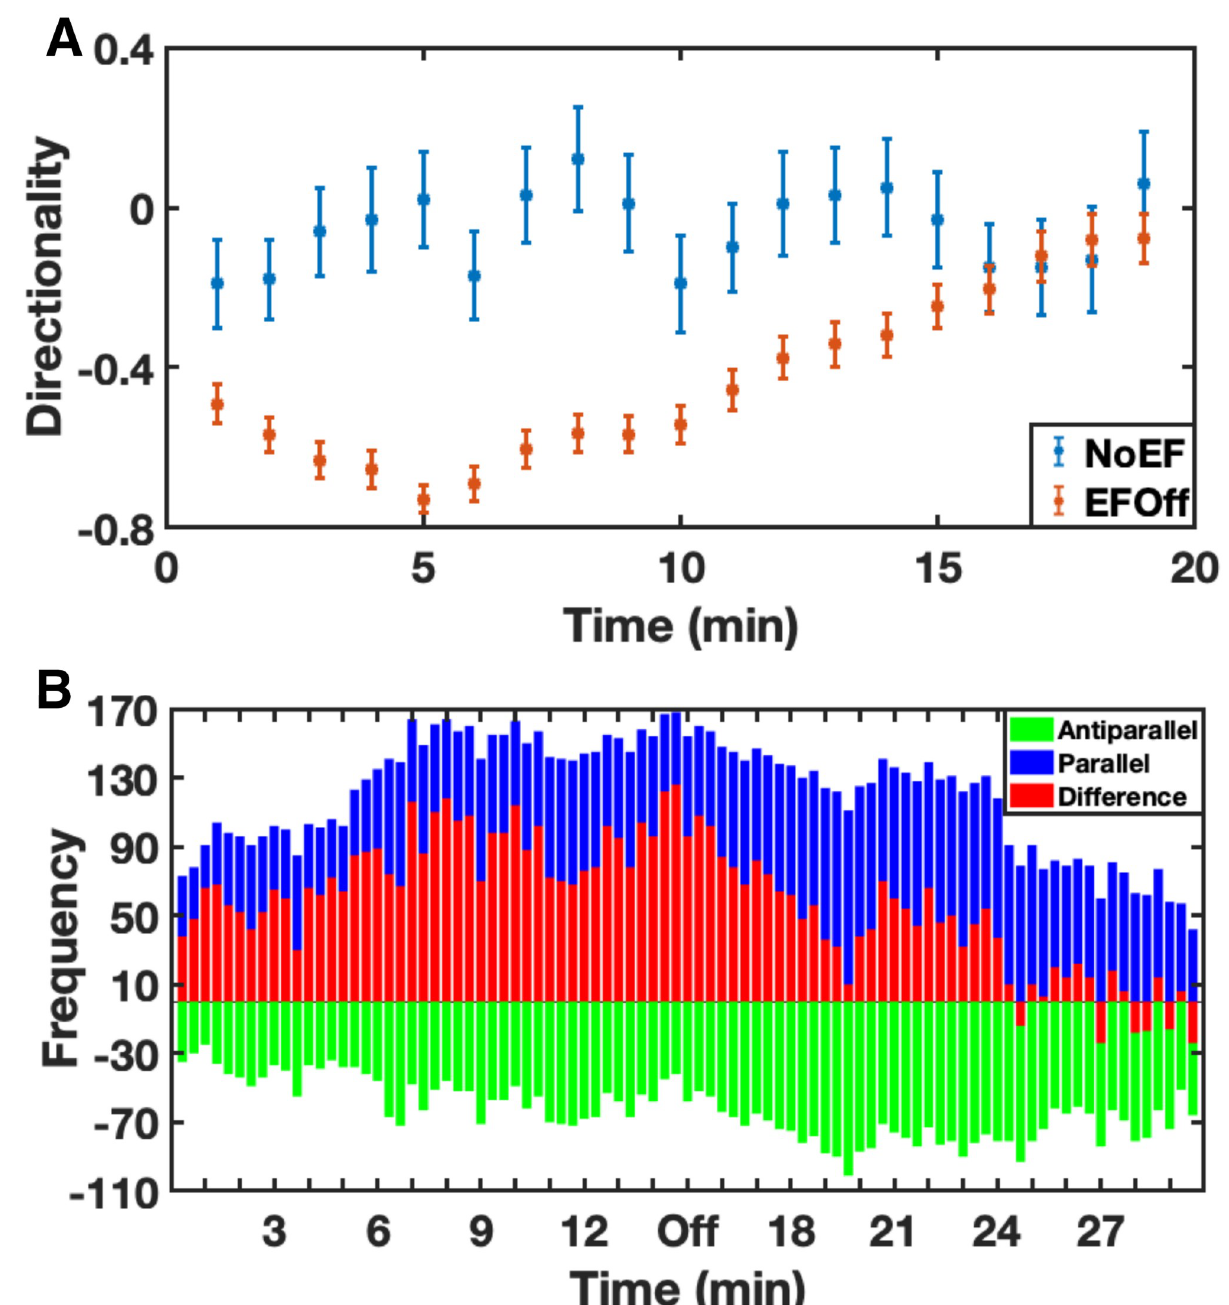
Fig 5. Electrical persistance without electric field. A. Directionality of Dd cells that were never exposed to electric field and move randomly (blue) and cells where the electric field was switched off after 90 min (red). The electric field was removed at t = 10 min. It is clear that the directionality decreases during the time after the field removal. The data are represented as mean ± s . e . m .B. F-actin localization inside the cell during the cellular migration and its dynamics when the electric field is switched off.